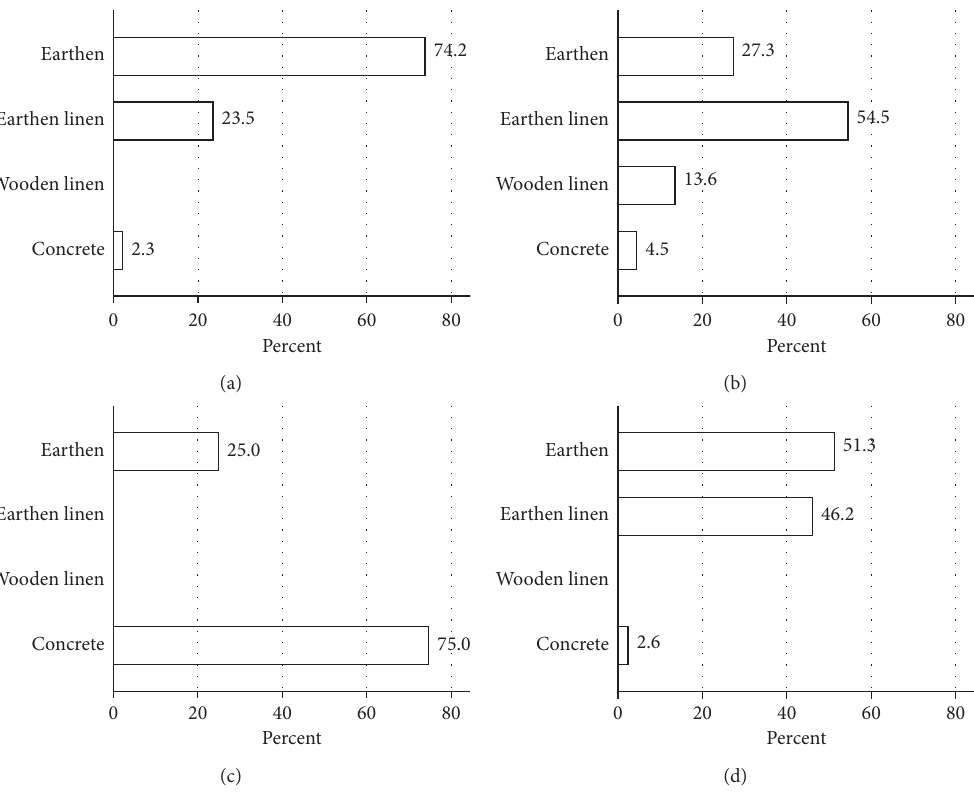
Figure 8: The type of pond used for farming each fish species. Tilapia was mainly reared in earthen ponds and catfish in earthen-linen, while rainbow trout was reared in concrete ponds. (a) Tilapia. (b) Catfish. (c) Rainbow trout. (d) Tilapia/catfish.